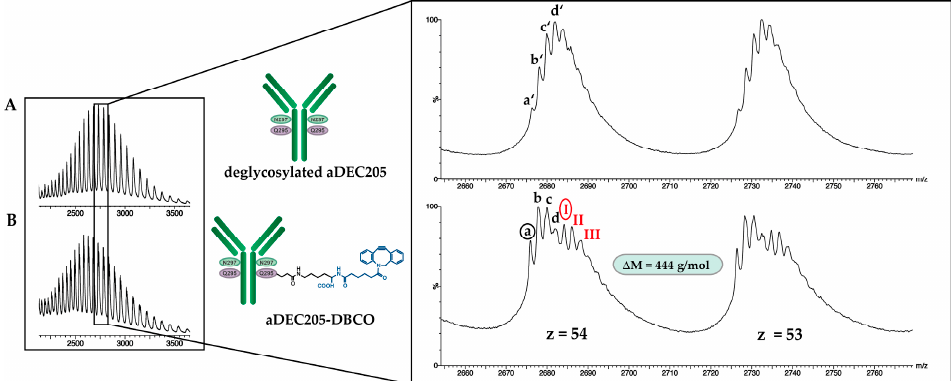
Figure 3. Mass spectra ( m / z ): ( A ) Deglycosylated aDEC205. ( B ) DBCO-modified aDEC205.